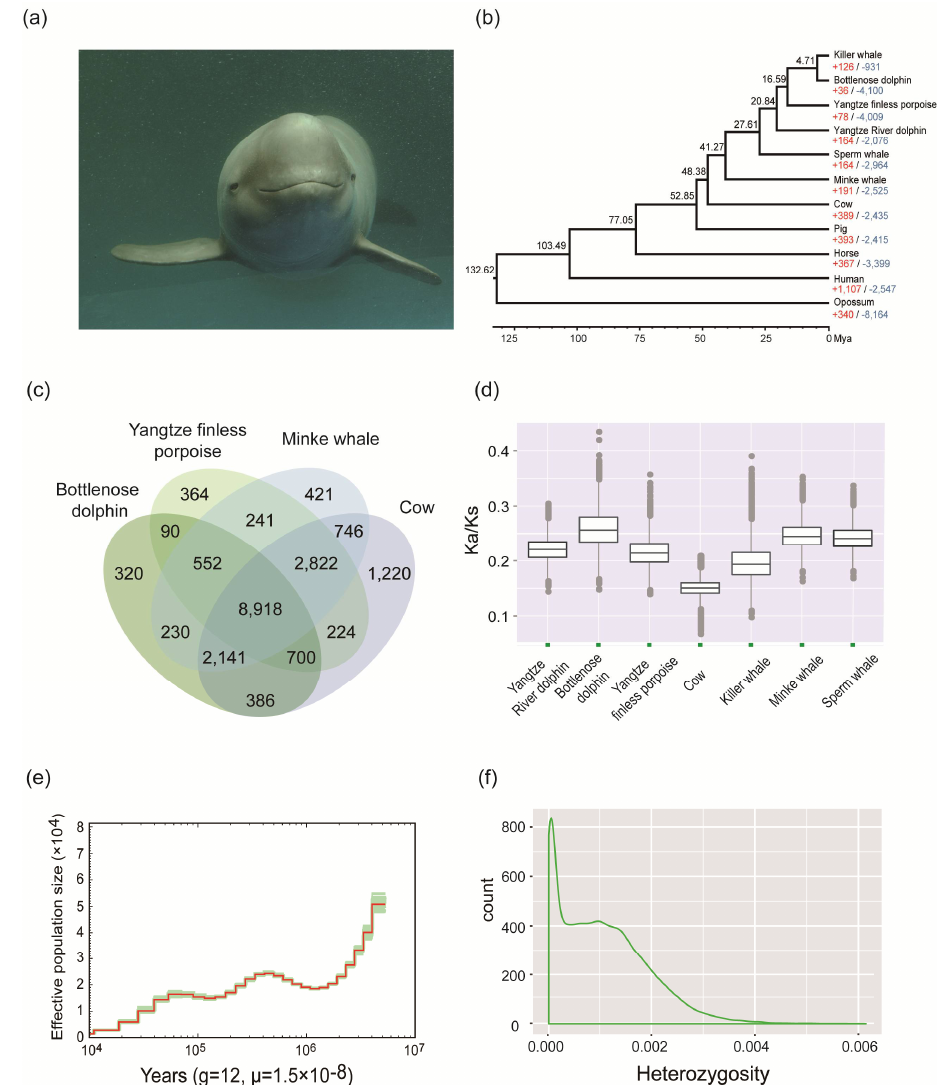
Figure 1. Gene families, phylogenetic relationships, and demographic history of the Yangtze finless porpoise. ( a ) Picture of a Yangtze finless porpoise (image from SL); ( b ) Phylogenetic tree constructed using the maximum likelihood approach and a comparison of gene family numbers. Black numbers next to the branches indicate divergence times, while the red and blue numbers indicate the number of gene families that have expanded or contracted, respectively, since the split from the common ancestor; ( c ) Venn diagram showing unique and overlapping gene families in the Yangtze finless porpoise, common minke whale, bottlenose dolphin, and cow genomes. Each number represents a gene family number; ( d ) Box-plot showing ratios of non-synonymous to synonymous mutations (Ka/Ks) in the Yangtze finless porpoise, Yangtze River dolphin, bottlenose dolphin, cow, killer whale, common minke whale, and sperm whale genomes; ( e ) Demographic history of the Yangtze finless porpoise constructed using the pairwise sequentially Markovian coalescence model; ( f ) Distribution of heterozygosity in the Yangtze finless porpoise genome (heterozygosity ratios of non-overlapping 50 K windows).